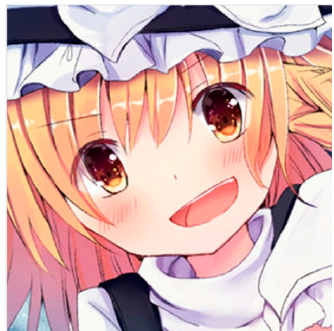
Figure 3. An example of the anime avatar image, from [44].